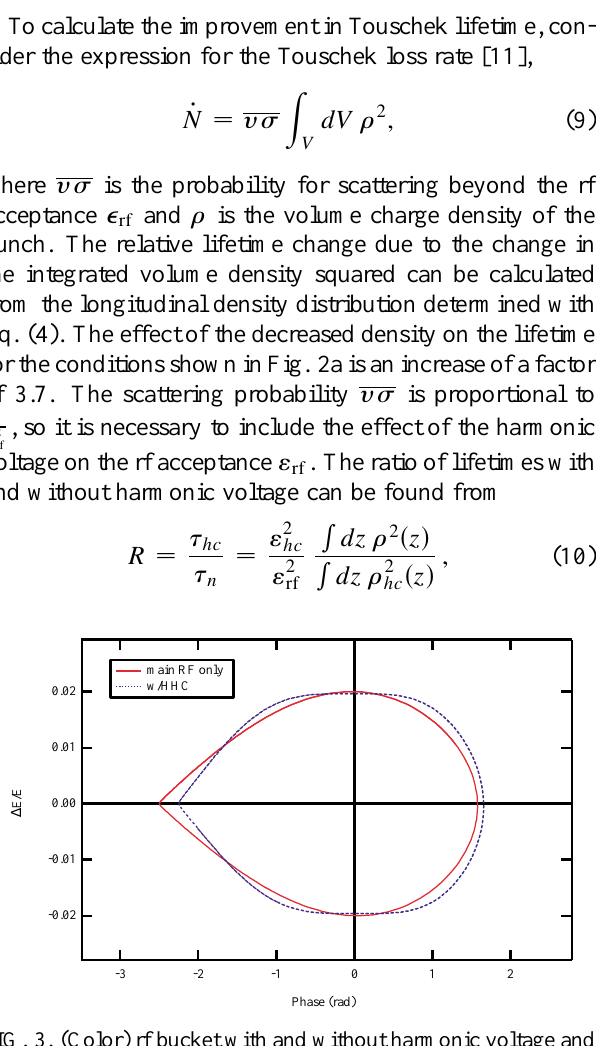
FIG. 4. (Color) Tuning of the fundamental mode of the har- monic cavity for reaching optimum bunch lengthening voltage and